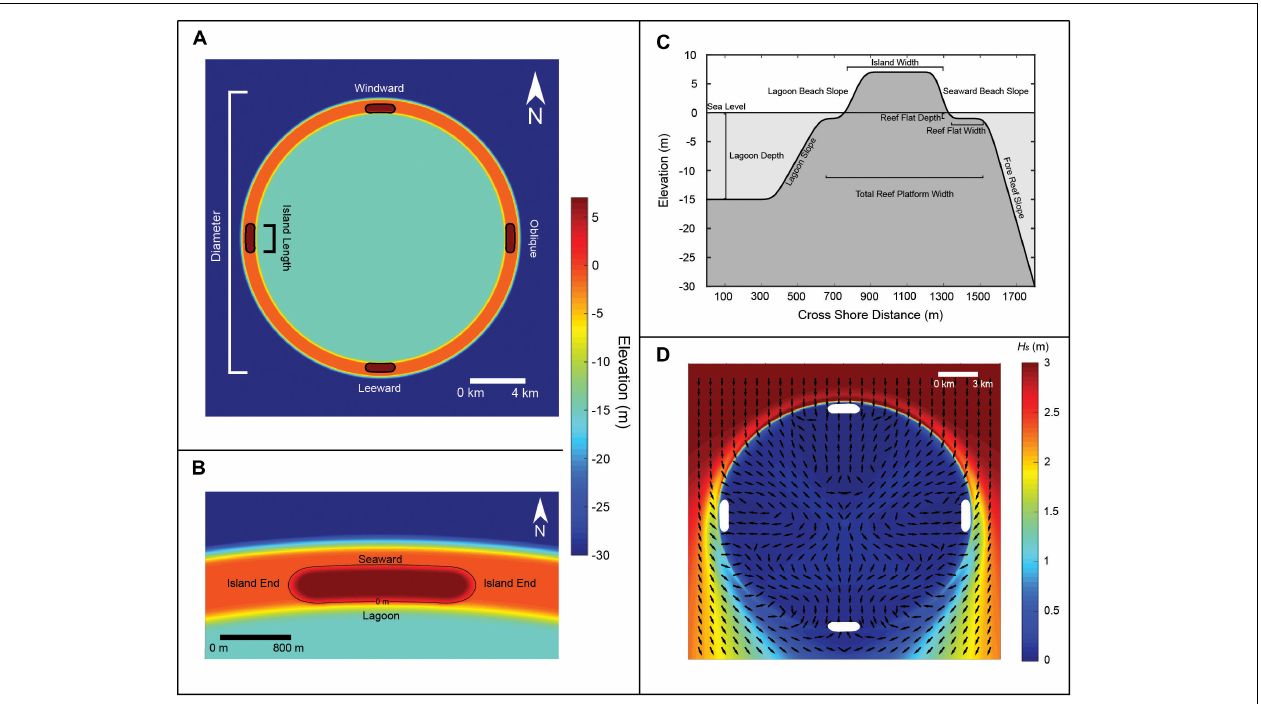
FIGURE 1 | Schematic model topography and bathymetry at the initial model configuration with example wave model output. (A) Topography and bathymetry at the atoll scale with labeled morphological parameters and island location in reference to incident waves coming from the top of the diagram. (B) A zoomed in image of the northern island indicating the shoreline divisions. Black lines indicate the 0 m contour. (C) Cross-section of schematized atoll island with labeled morphologic parameters. (D) Example wave height output for a 20 km atoll. White areas represent islands; black arrows represent wave direction. Waves approach from the top boundary of the model domain and refract around the atoll.